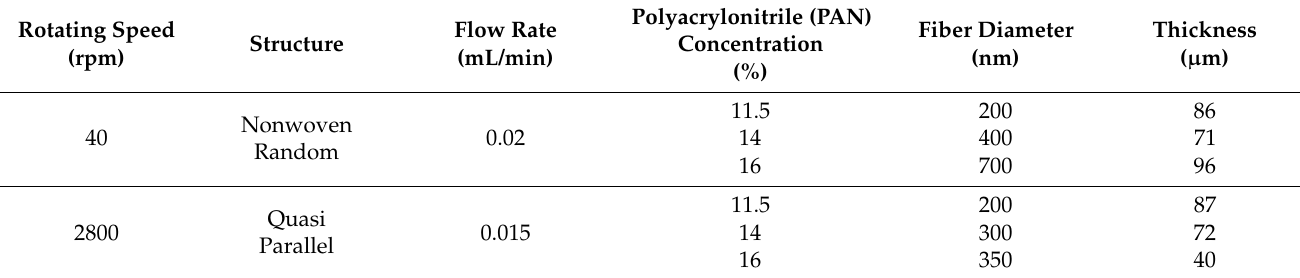
Table 1. Electrospinning processing parameters and the resulting fibrous membrane